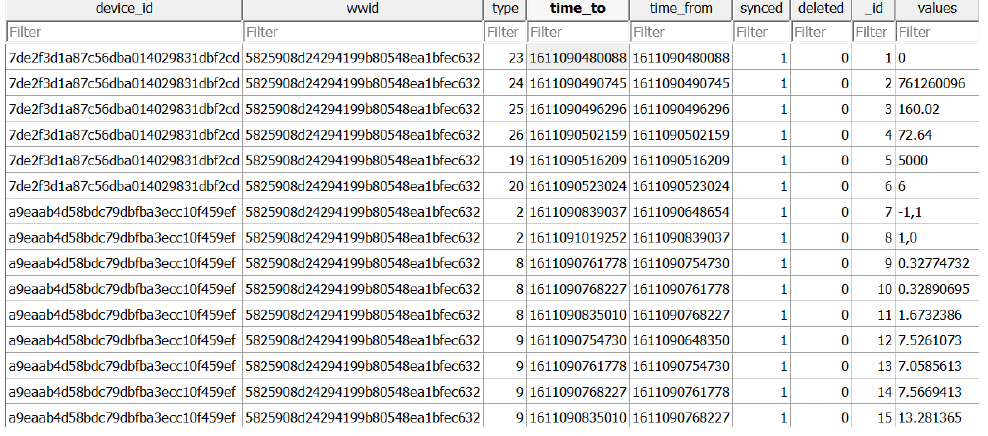
Figure 26. Reduced view of health-related data recorded by the